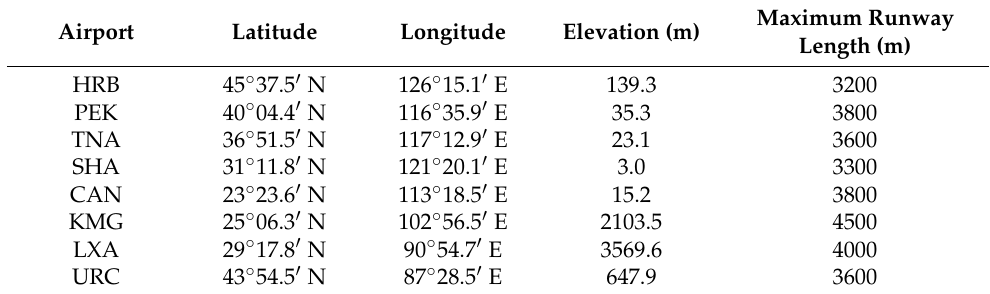
Table 1. The selected Chinese airports’ information. Data obtained from Aeronautical Information Publication (AIP)